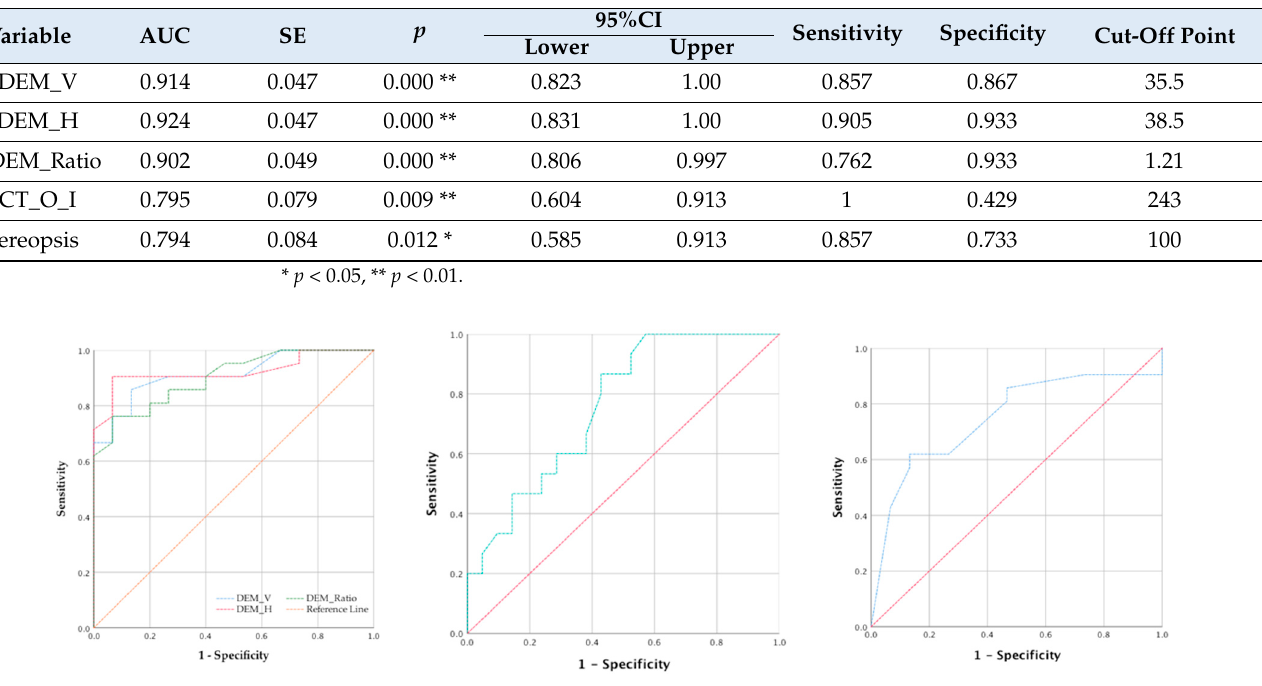
Figure 4. ROC curve analysis about ADEM, OCT_O_I, and stereopsis. Table 5. ROC curve analysis about DEM, stereopsis, and